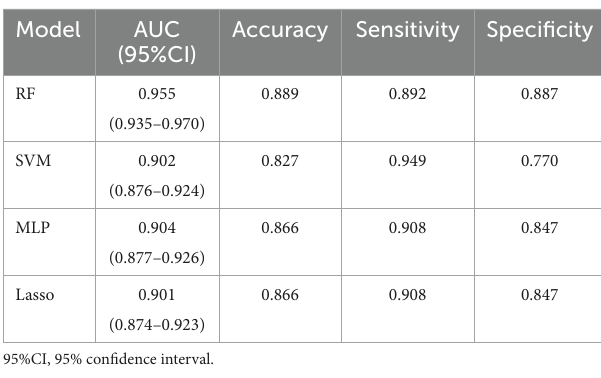
TABLE 4 Performance of different machine learning models on the testing set.